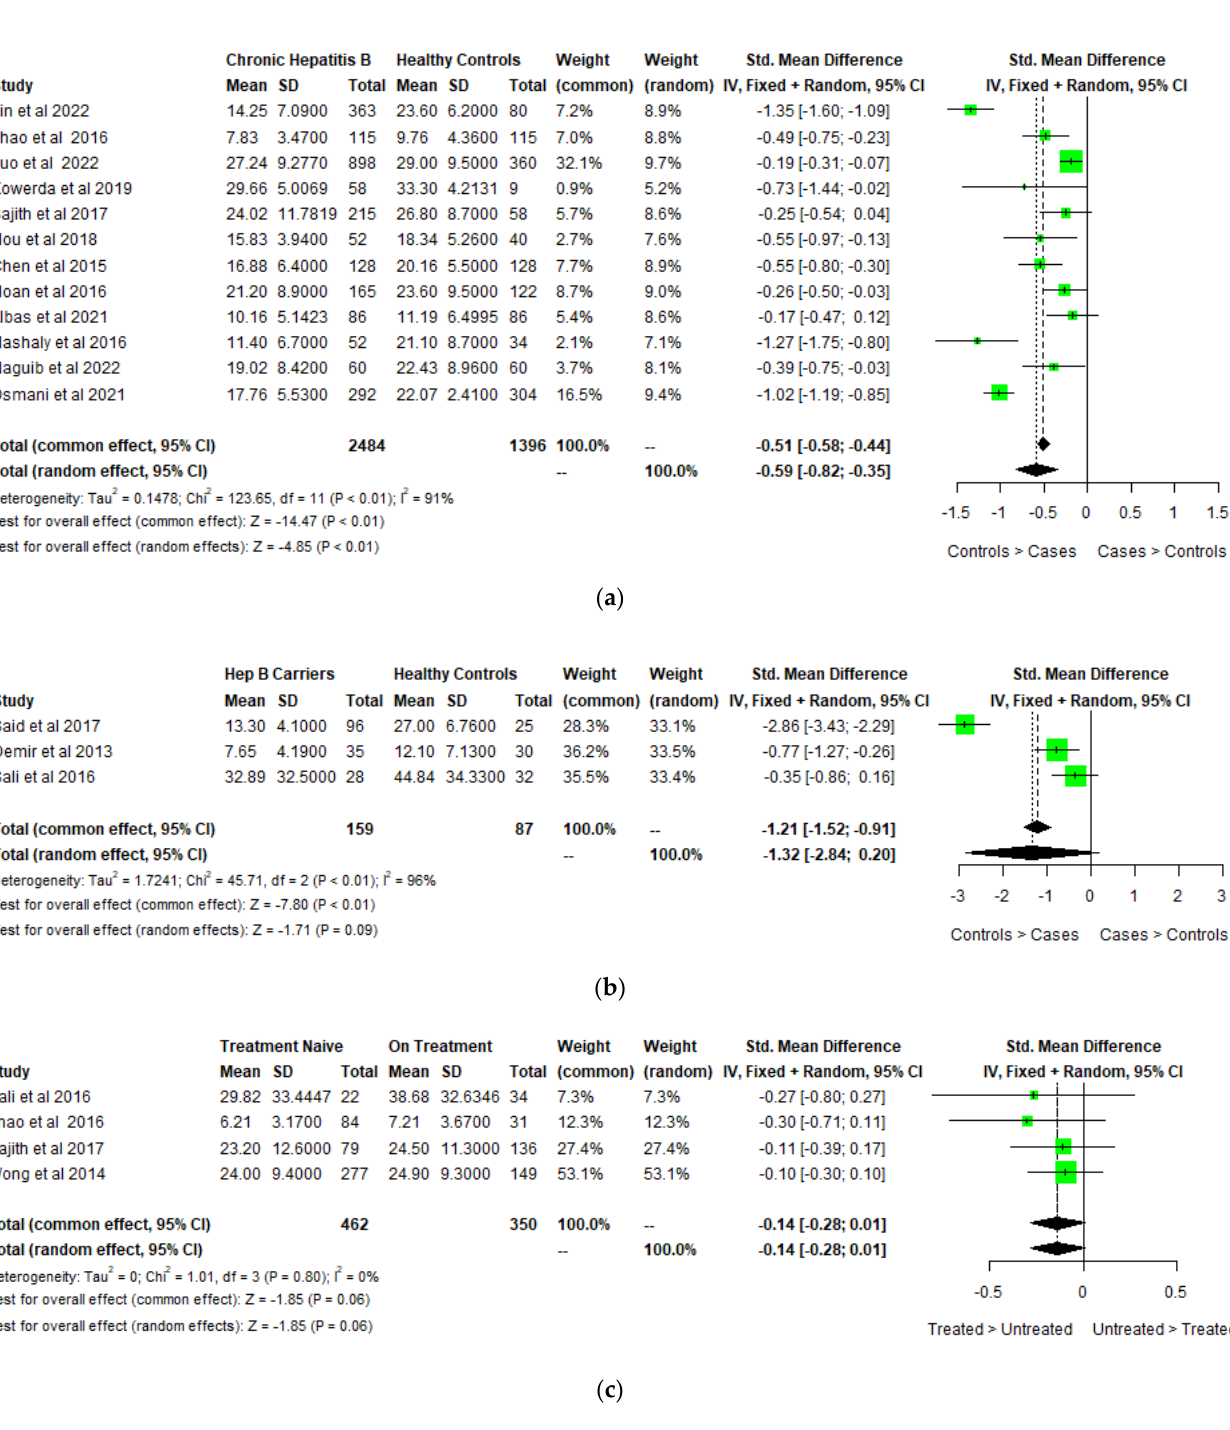
Figure 2. Forest plot of vitamin D levels between ( a ) CHB cases and healthy controls [9,21–31], ( b ) inactive HBV carriers and healthy controls [18–20], ( c ) treatment-naïve and on-treatment Hepatitis B patients [20,22,25,41]. The funnel plot for 25-hydroxy-vitamin D levels in CHB versus healthy controls is asymmetrical, as shown in Figure 3a. The Egger’s test, however, suggested no evidence of potential publication bias ( p = 0.4143).